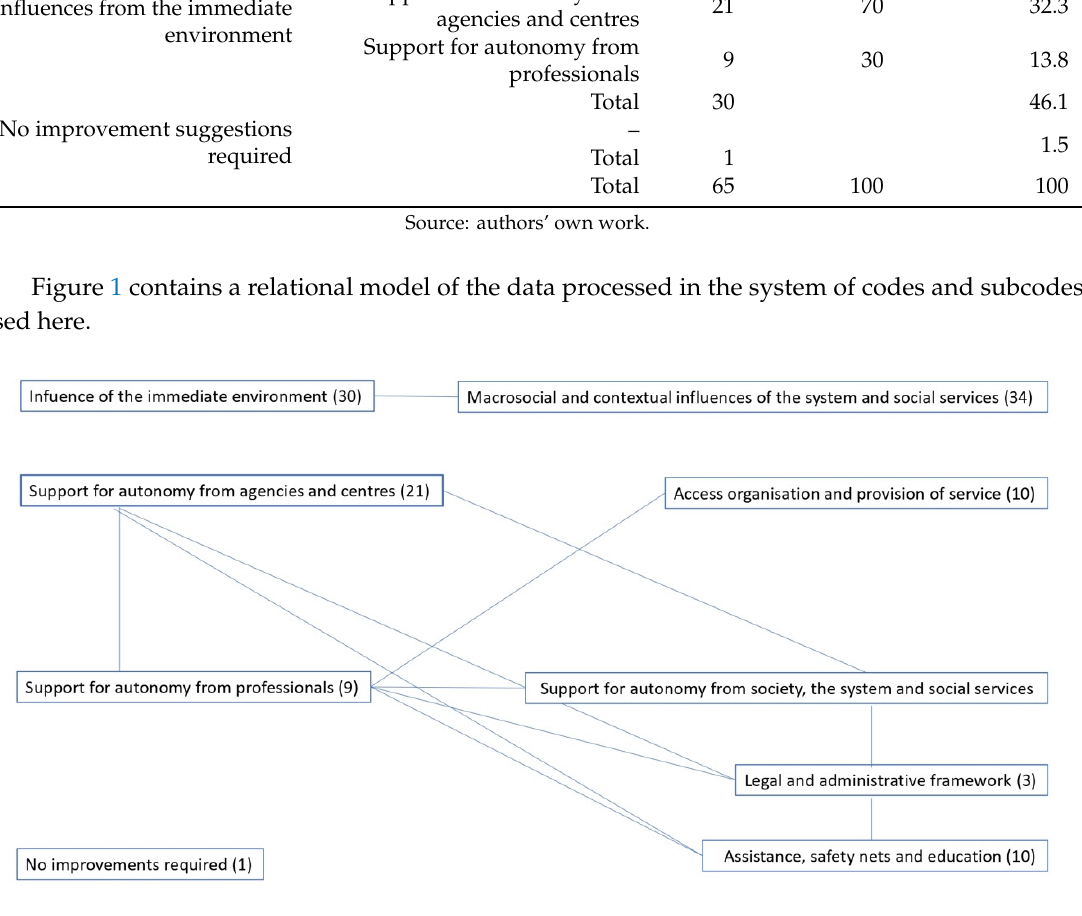
Table 2. Detail of contributions and percentages of suggestions on the management and use of time with young people during their transition to adulthood (frequency of contributions, N).